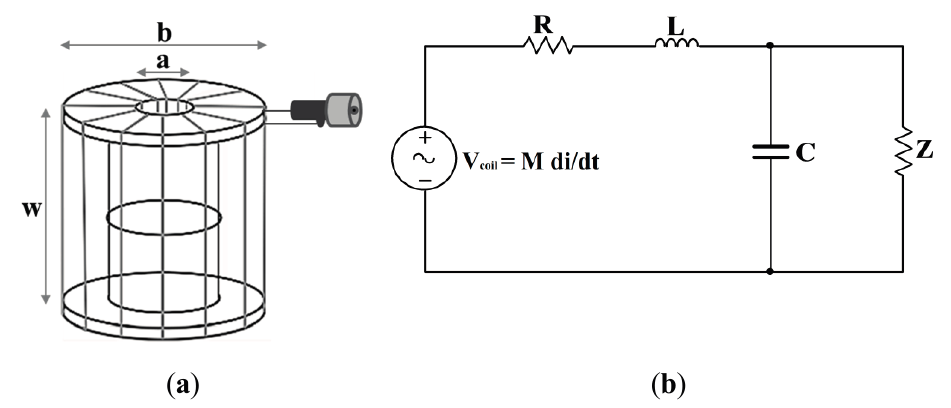
Figure 1. ( a ) Rogowski Coil; and ( b ) its electric equivalent